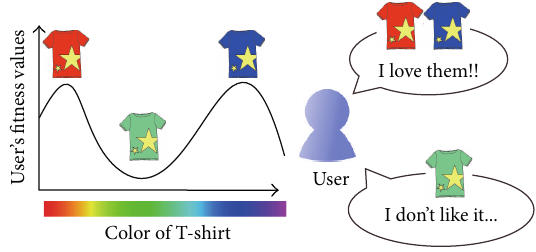
Figure 3: Landscape representation of multimodal Kansei.